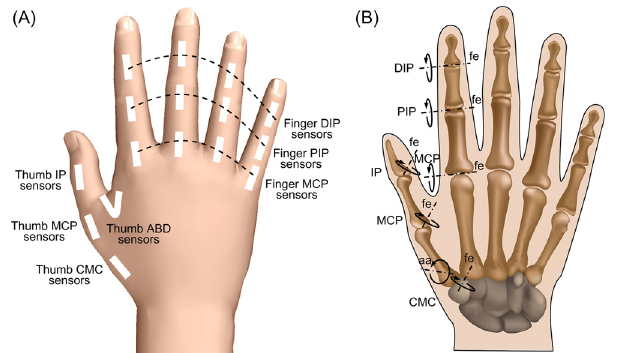
Fig 1. CyberGlove sensor placement and corresponding kinematic model of human hand. (A) Placement of 16 sensors used in the CyberGlove (the image is adapted from Ingram 2008, with kind permission from Springer Science + Business Media). (B) Joints and the kinematic model of the human hand. Abbreviations: MCP, metacarpal-phalangeal; PIP, proximal inter-phalangeal; DIP, distal inter-phalangeal; CMC, carpometacarpal; IP, inter-phalangeal; ABD, abduction; T, thumb; I, Index; M, Middle; R, Ring; L, Little; fe, flexion-extension; aa,